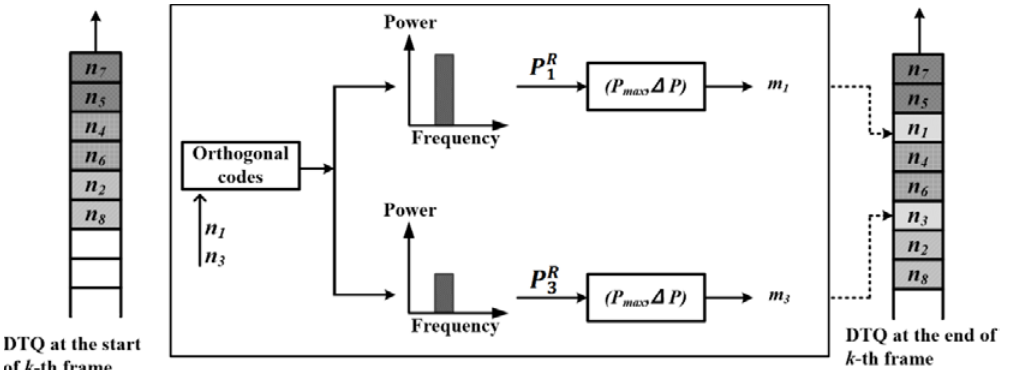
Figure 3. Example of the priority assignment operation in OrMAC.